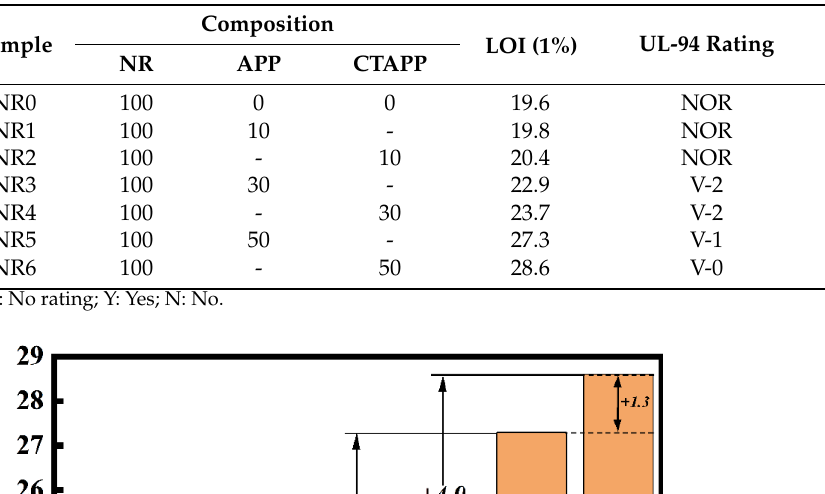
Table 2. Composite formulation and LOI, UL-94 test data.